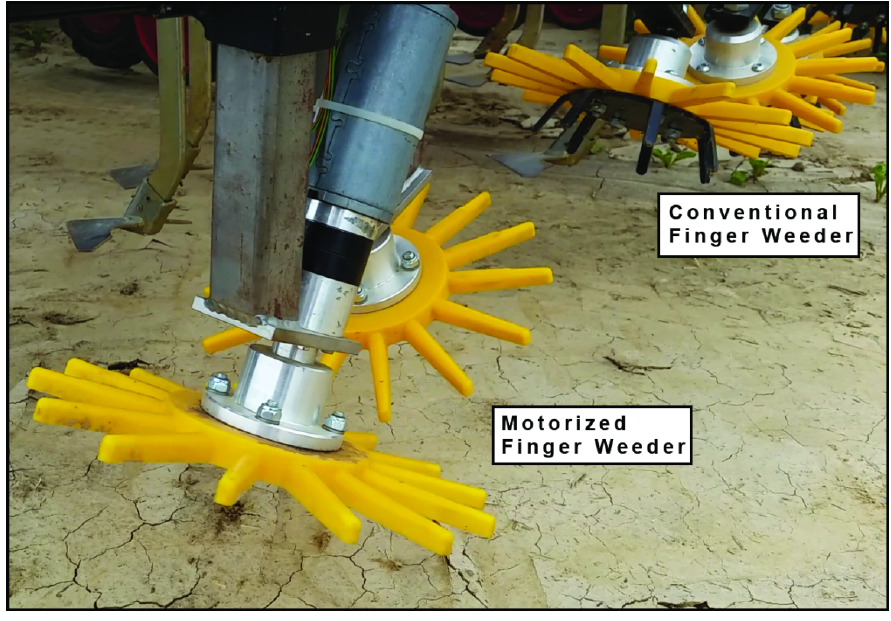
Figure 2. Normal and motorized finger weeders and their principles of